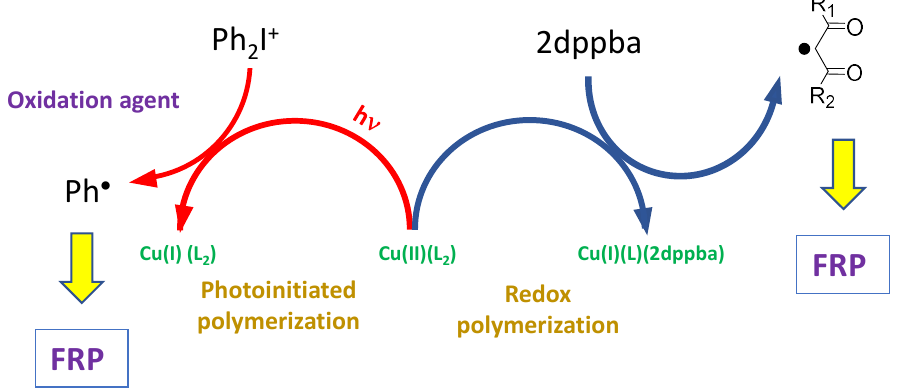
Figure 29. The dual source of radicals upon photoactivation of the redox process.